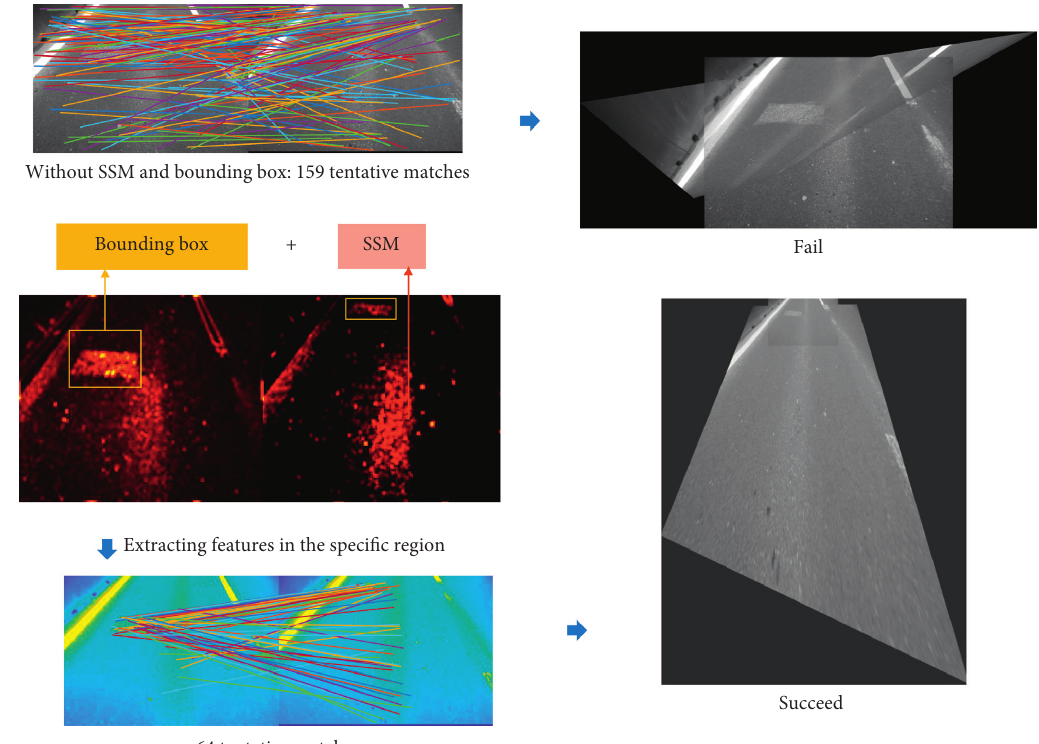
Figure 11: Feature extraction and image stitching using SSM and a bounding box.